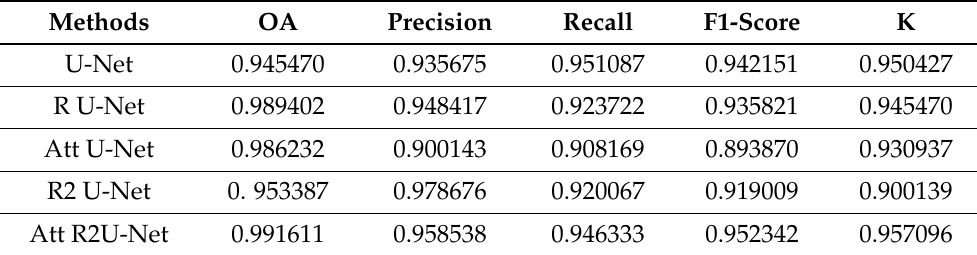
Table 16. Quantitative results for hyperspectral images